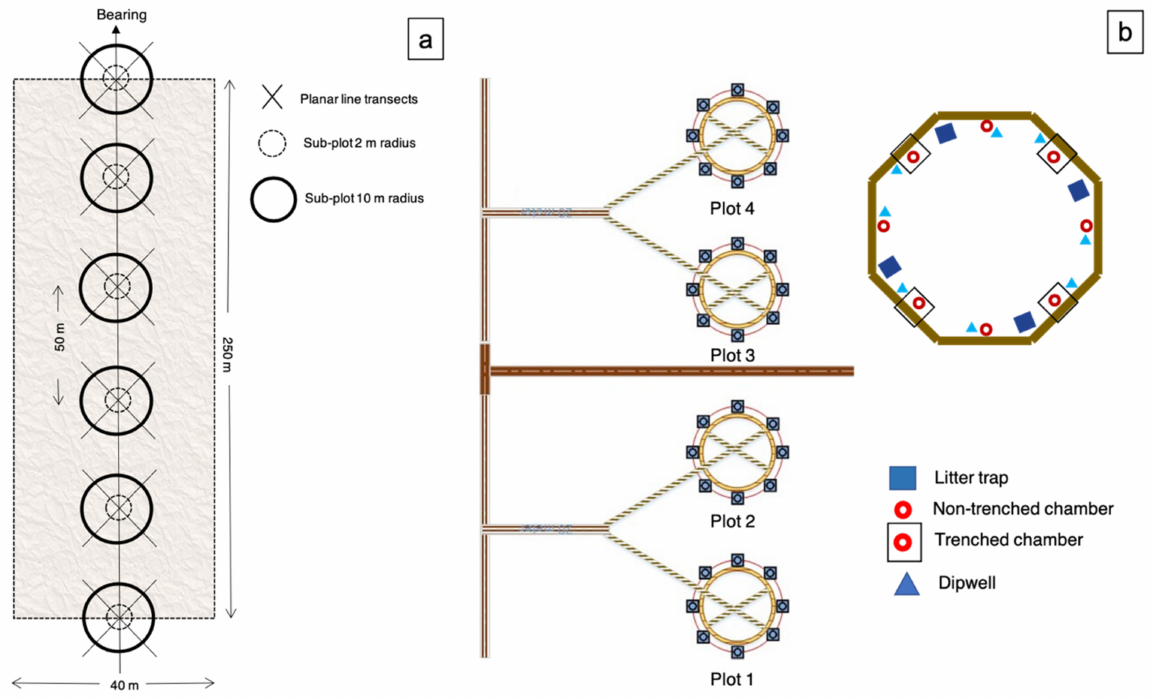
Figure 2. Panel ( a ) shows a carbon stock plot layout modified from Kauffman et al. (2016). Panel ( b ) shows the chambers and litter trap layout in each sub-plot; the distance between plots is 100 m. In each plot, there are 8 permanent chambers (4 trenched and 4 non-trenched), 4 litter traps, and 8